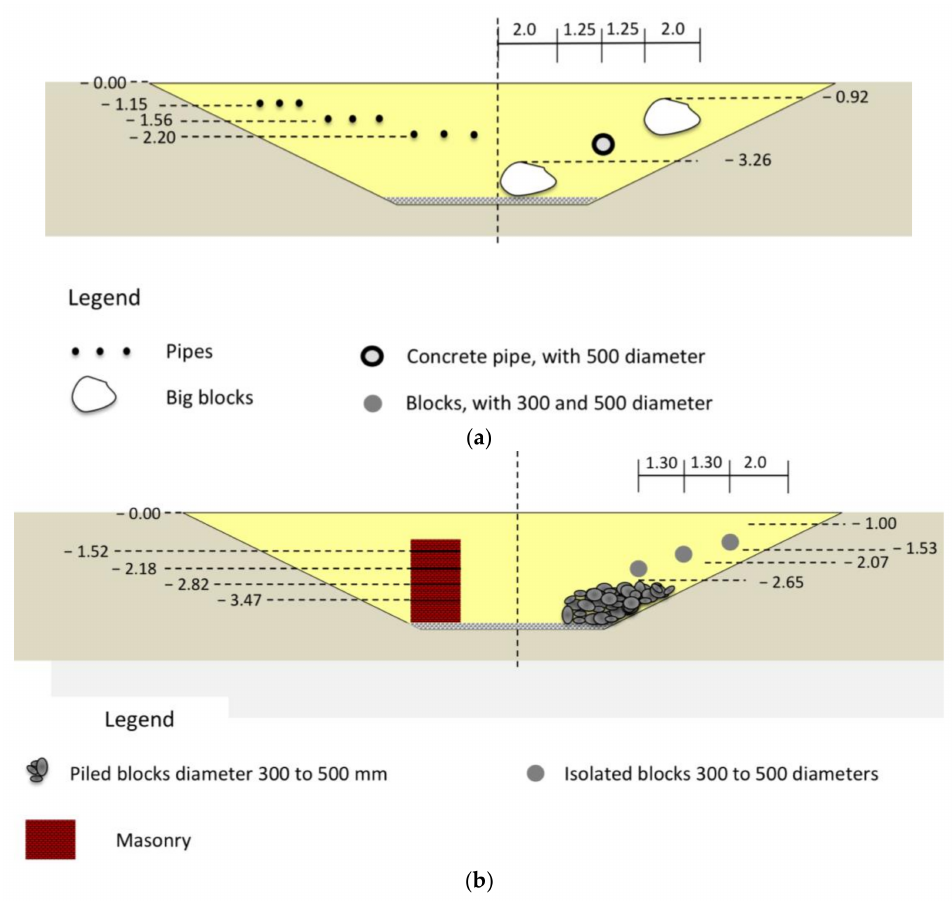
Figure 13. Transversal sections of the Gneiss 0/20 gravel region: ( a ) First part; ( b ) second part. The embedded objects and their positions are shown. All distances are expressed in meters.